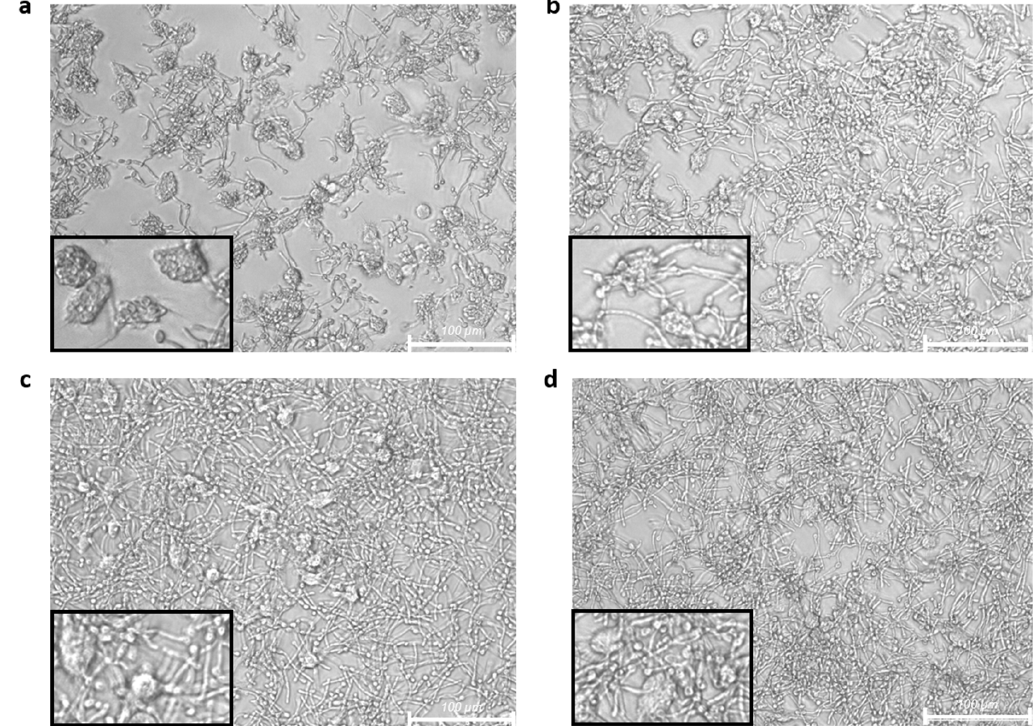
Figure 5. Phagocytosis of C. albicans mediated by M1 macrophages after treatment with different formulations of SFN. LPS stimulated (0.1 µ/mL) human M1 macrophages from 4 healthy donors were untreated ( a ) or treated for 24 h with unloaded broccoli membrane vesicles 0.02 mg/mL ( b ), free sulforaphane (SFN) 25 µM ( c ), or SFN-loaded broccoli membrane vesicles at 25 µM ( d ). After withdrawal of medium, the cells were cocultured for 2 h with C. albicans from exponential phase cultures, at 1:5 ratio and then washed with PBS. Representative images from optical microscope with 20× magnification are shown. Bar scale is 100 µm.